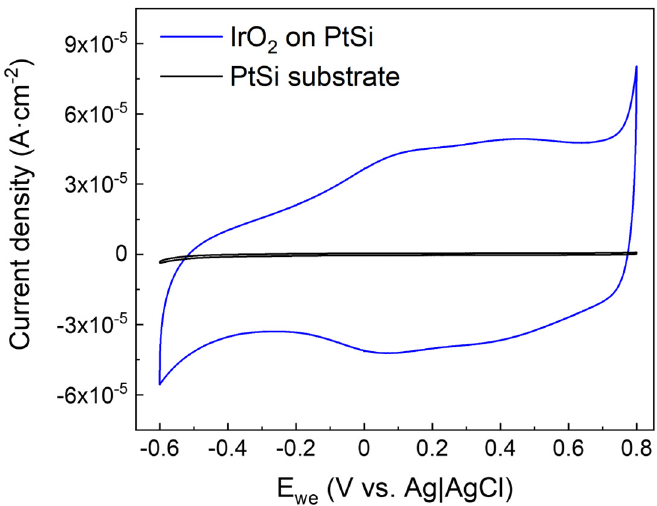
Figure 10. Cyclic voltammograms of ALD-prepared IrO 2 deposited onto PtSi (blue curve) and of the bare PtSi substrate (black curve). The higher current density of IrO 2 can be attributed to the pseudocapacitive properties of IrO 2 . Both CV curves reported are acquired after 50 cycles of stabilization, with a scan rate of 50 mV · s − 1 .